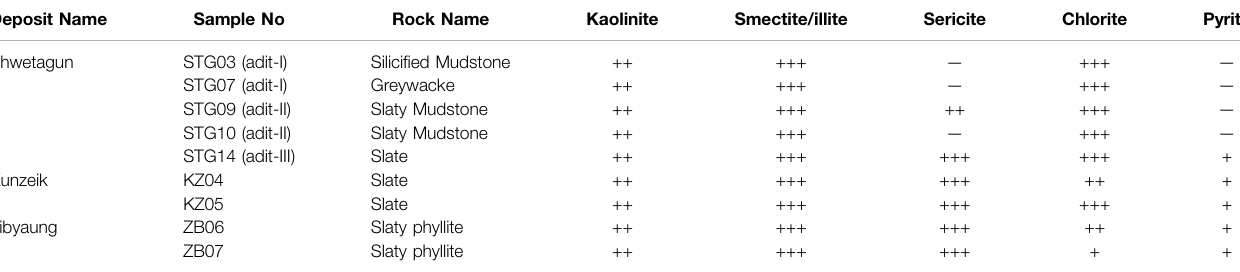
TABLE 1 | Summary of hydrothermal alteration from orientated samples analyzed by XRD and